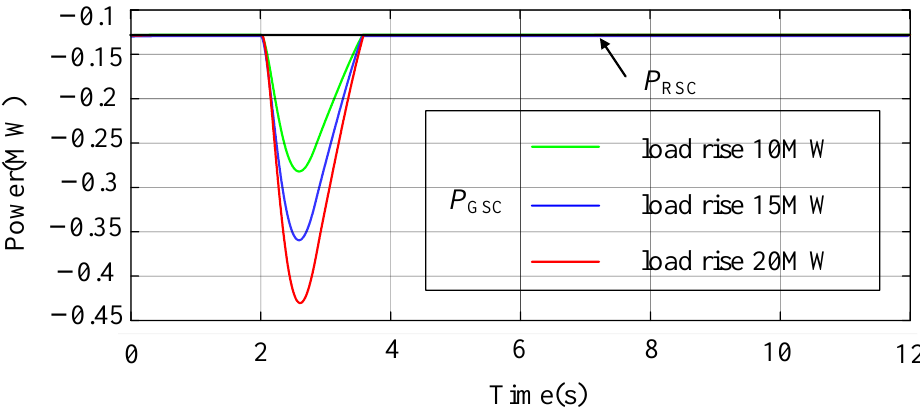
Figure 22. GSC and RSC running status curves of DFIG at medium wind speed. As shown in Figures 19–21, compared with the low wind speed, the wind turbine output power increased at a medium wind speed, the initial operating power of the P2H increased, and the load shedding capacity became stronger. In the process of frequency regulation, a P2H device is the main body of the power response, and a SCESS only needs to compensate for the difference that the P2H device cannot track the frequency regulation command. Here, in the medium wind speed state, the system frequency deviations under the different surge loads were 0.21 Hz, 0.32 Hz and 0.42 Hz, respectively, which had a favorable frequency regulation effect. As shown in Figure 22, the wind turbine ran in an over-synchronous operation state at this time, the slip rate s was less than 0, the power flowing through the RSC was − 0.128 MW, and the power flowing through the GSC was the difference between the SCESS power released and itself.